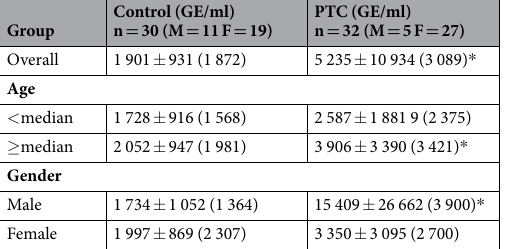
Table 1. Levels of cf-nDNA in study groups. Data are expressed as mean ± standard deviation (median). GE- genome equivalents. * Statistically significant data corresponding control, p ≤